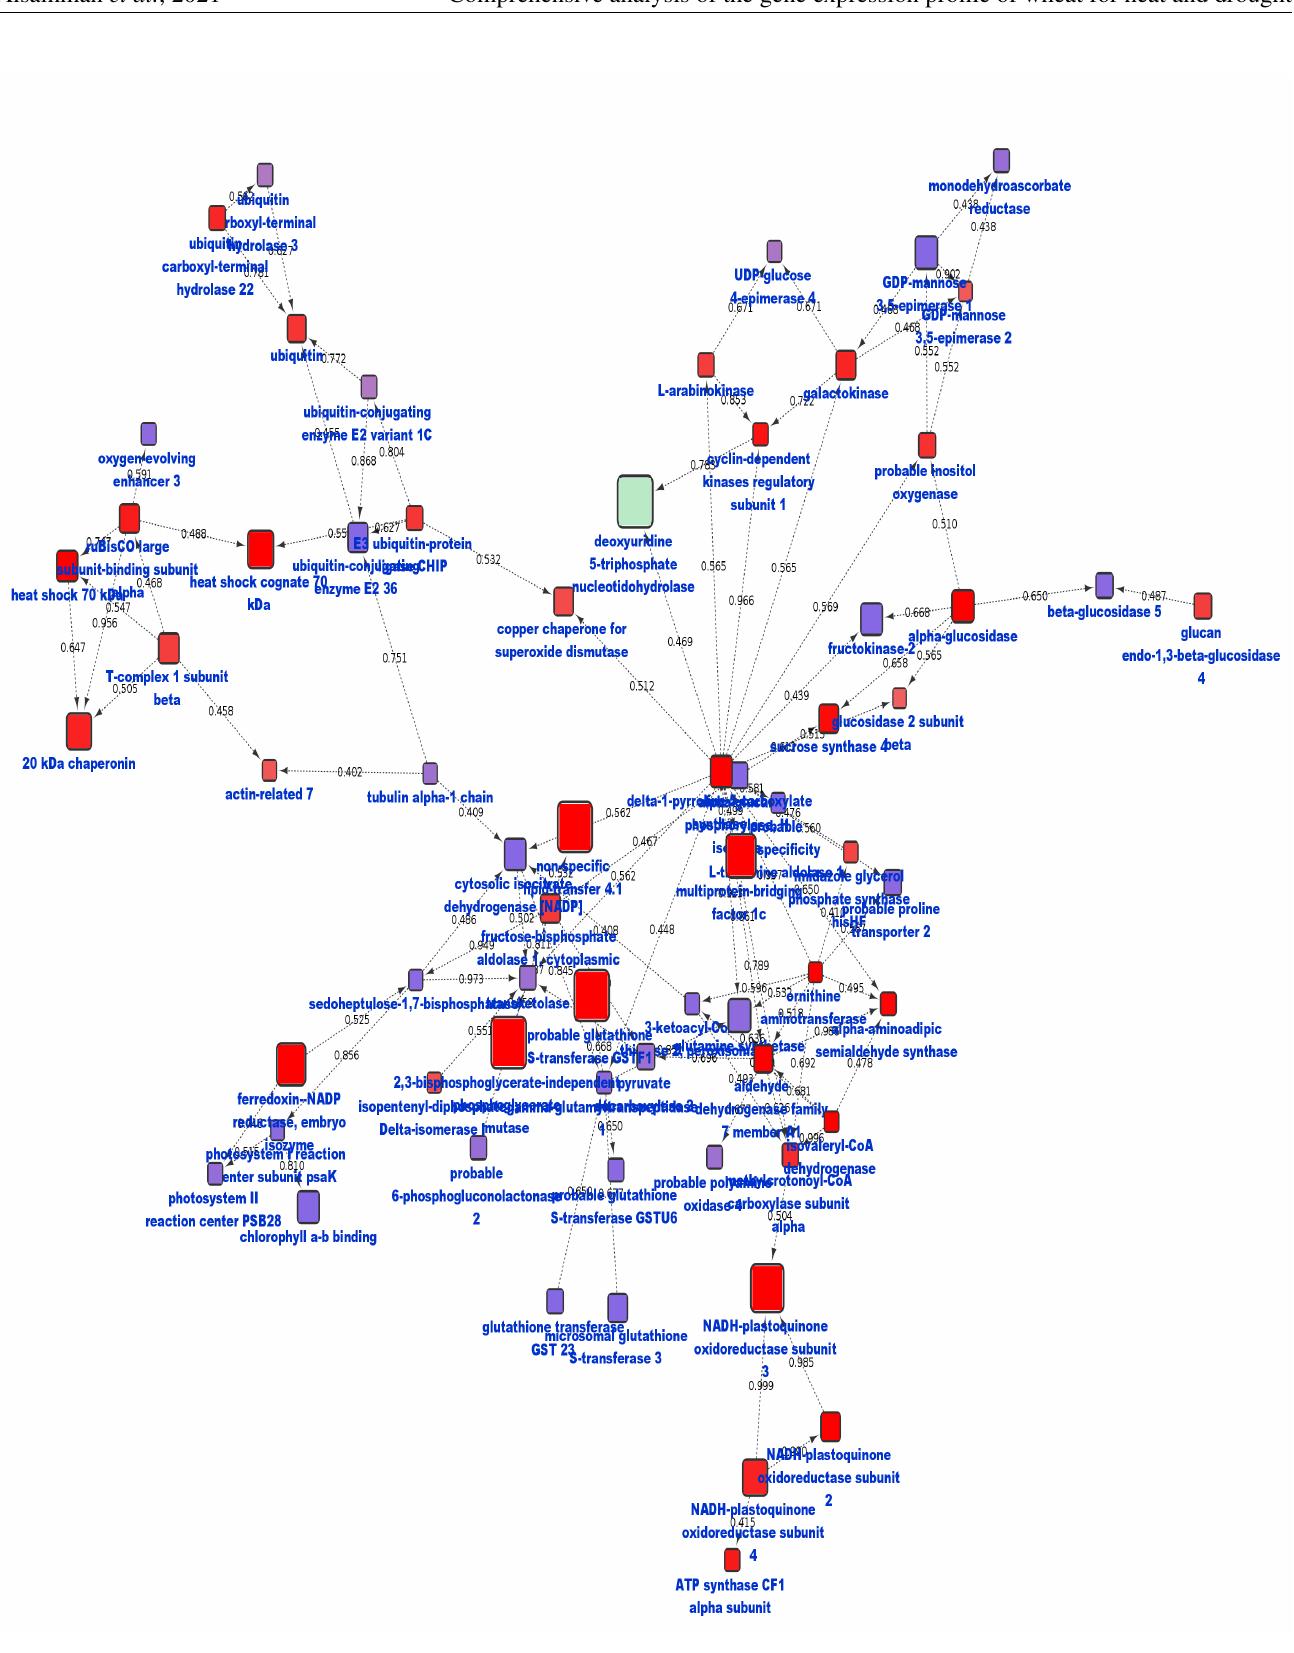
Figure 8. The protein-protein interaction networks of DEGs genes of M.ctrl gene profile. The node size and color stand for gene significance (logpvalue) and gene expression (LogFC)